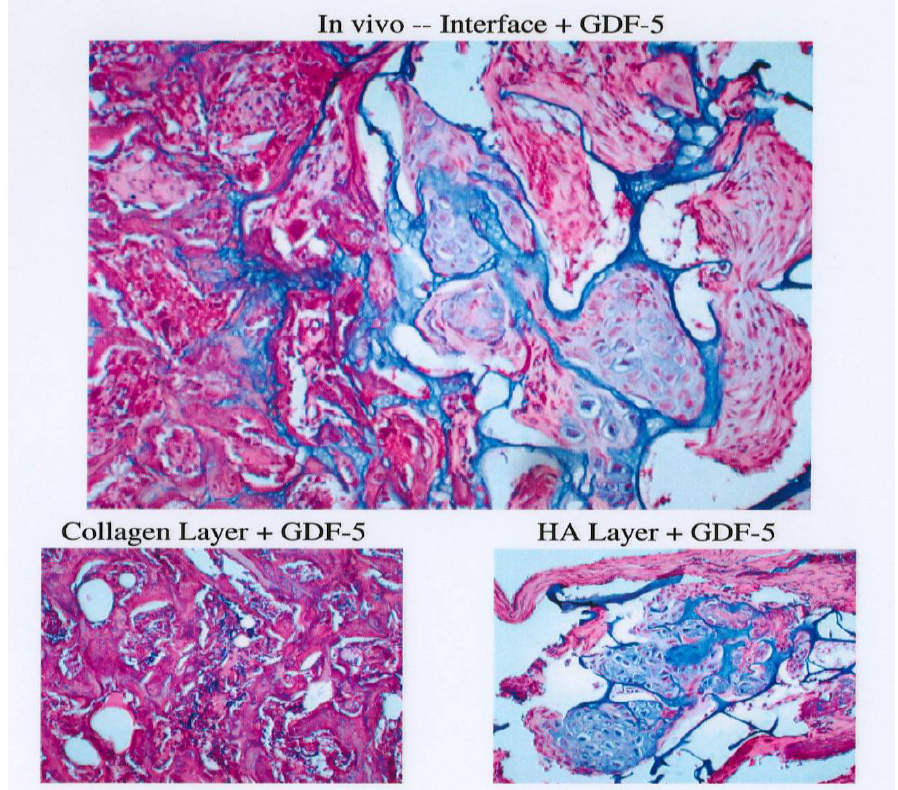
Figure 6. HA/COL Bilayered matrix was loaded with rhGDF-5 and implanted in rats intramuscularly. Two weeks post implantation, rats were sacrificed, and the implants with surrounding tissues were examined for histology. The top is the interface between the two layers, the HA layer is on the left side, the COL layer is on the right side. The COL layer induces a significant amount of bone formation and a trace of cartilage, whereas cartilage and young bone are predominated in the HA layer